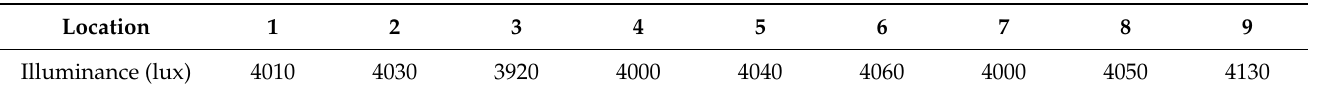
Figure 2. ( a ) LED light tripods around the slab and ( b ) the pattern of measuring the luminous flux on the sample surface as indicated by the numbers. Table 2. Illuminance measurement results on the sample surface. Locations correspond to markings in Figure 2b.